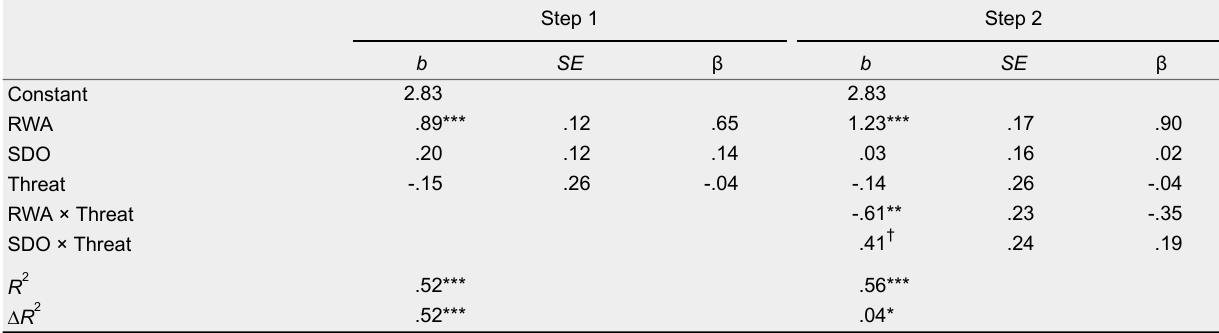
Study 2: Moderated multiple regression analysis for the full RWA scale (N =